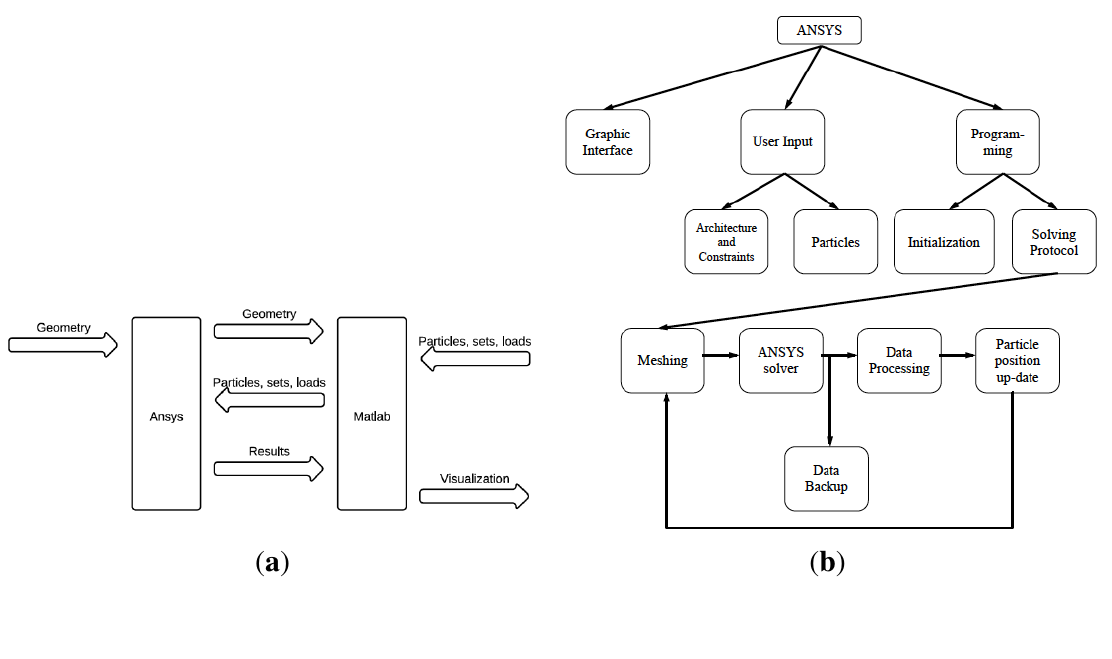
Figure 4. Modeling approach set-up steps using implemented MATLAB and ANSYS